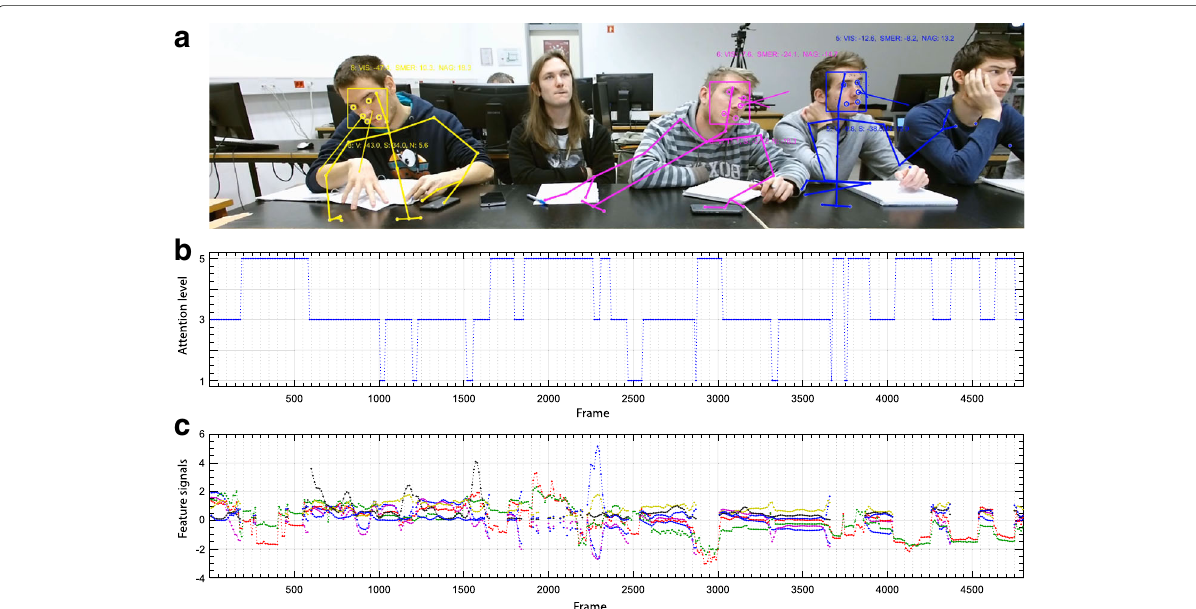
Fig. 5 Examples of final feature set for test person 6. Image ( a ) represents a single frame of Kinect video with visualization of Kinect data including face rectangles, face points, gaze vectors, and body skeletons. Graph ( b ) shows reference attention level, and graph ( c ) shows seven normalized and smoothed feature